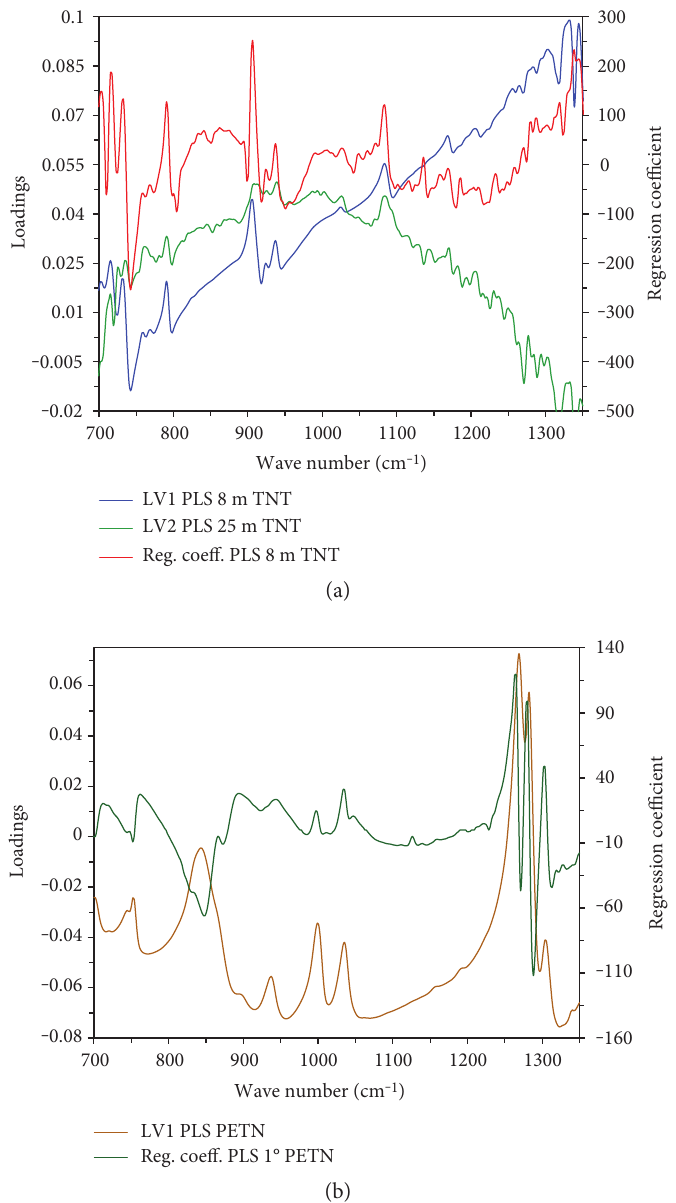
Figure 6: (a) Regression coe ffi cient and loading plot for PLS model of detection of TNT explosives on Al plates at 8m stando ff distance. (b) Regression coe ffi cient and loading plot for PLS model of detection of PETN explosives on Al plates at 1m stando ff distance and angle of collection 1 °